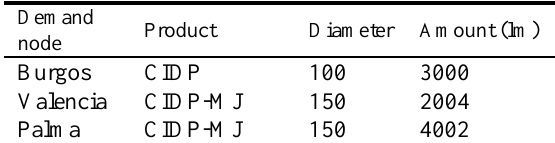
Table 4. ipe demand f m the dema -nodes considered